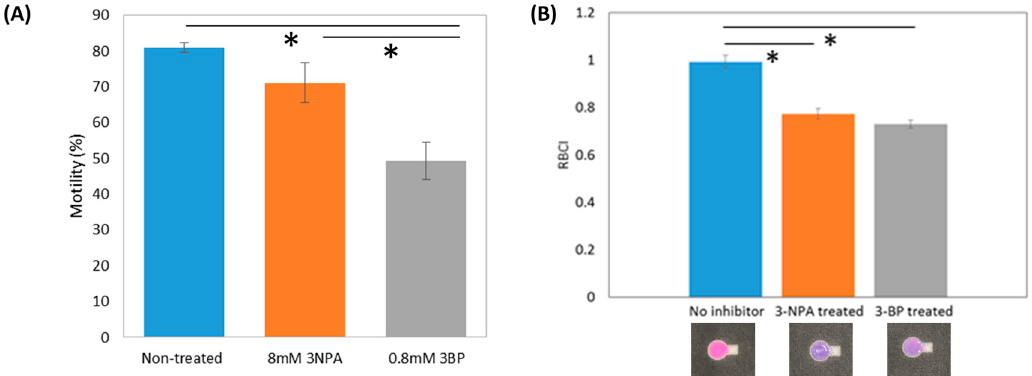
Figure 3. ( A ) Comparison of average motility for 60 min treatment without and with inhibitors (* p < 0.025); ( B ) comparison of average RBCI for 60 min treatment without and with inhibitors (* p < 0.025). Sample numbers of the groups without inhibitor, with 3-NPA treatment, and with 3-BP treatment were 12, 8, and 10, respectively. Error bars are standard errors (SE) of motility and average RBCIs.